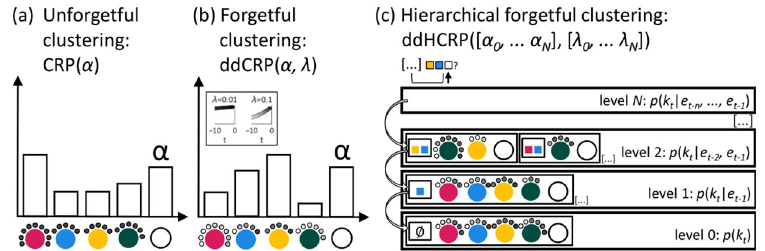
Fig 3. Treating the sequence learning problem as an hierarchical nonparametric clustering problem. (a) The traditional, unforgetful Chinese restaurant process (CRP) is a nonparametric Bayesian model where the probability that a new observation belongs to an existing cluster or a new one is determined by the cluster sizes and the strength parameter α . In the metaphor, the new customer (new observation; see the terminology in Table 1; shown as black dots) sits at one of the existing tables (clusters labeled by key press identity, e.g., ‘response to left side of the screen’; shown as colored circles) or opens up a new table (shown as open circle) with probabilities proportional to the number of customers sitting at the tables and α . Here, the most likely next response would be of the type pink . (b) The distance- dependent or ‘forgetful’ Chinese restaurant process (ddCRP) is governed by a distance metric, according to the ‘close together sit together’ principle. In our case, the customers are subject to exponential decay with rate λ , as shown in the inset (and illustrated by the grey colours of the customers). Even though the same number of customers sit at the tables as in (a), this time the predictive probability of a yellow response is highest because most of the recent responses were yellow . (c) In the distance-dependent hierarchical Chinese restaurant process (HCRP), restaurants are labeled by the context of some number of preceding events and are organized hierarchically such that restaurants with the longest context are on top. Thus, each restaurant models the key press of the participant at time point t , k t , given a context of n events ( e , ... e ). A new customer arrives first to the topmost restaurant that corresponds to its context in the data t − n t − 1 (in the example, the customer is bound to visit the restaurant labeled by the context ‘yellow-blue’ when he arrives to level 2). If it opens up a new table, it also backs off to the restaurant corresponding to the context one element shorter (in the example, to the restaurant labeled by the context ‘blue’).